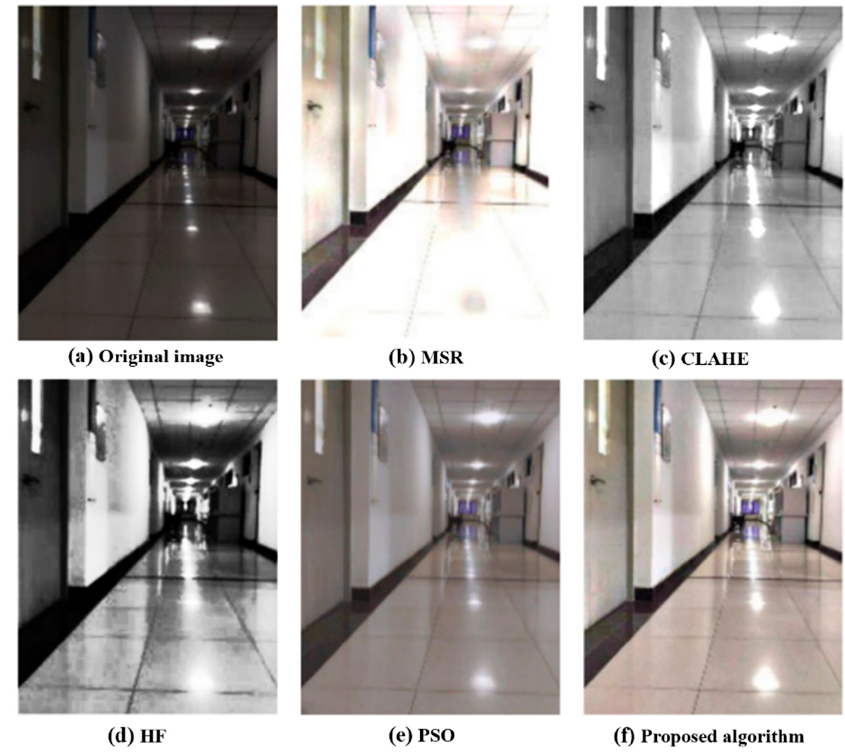
Figure 8. Comparison corridor image enhancement effect.